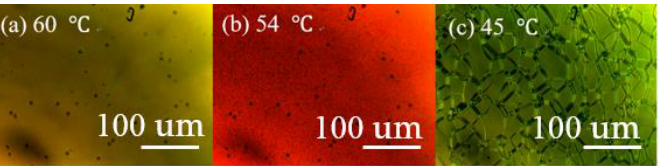
Figure 3. POM images of the PS-BPLC precursor with: ( a ) isotropic phase (60 °C ) ; ( b ) blue phase (54 °C); ( c ) cholesteric phase (45 °C ) .